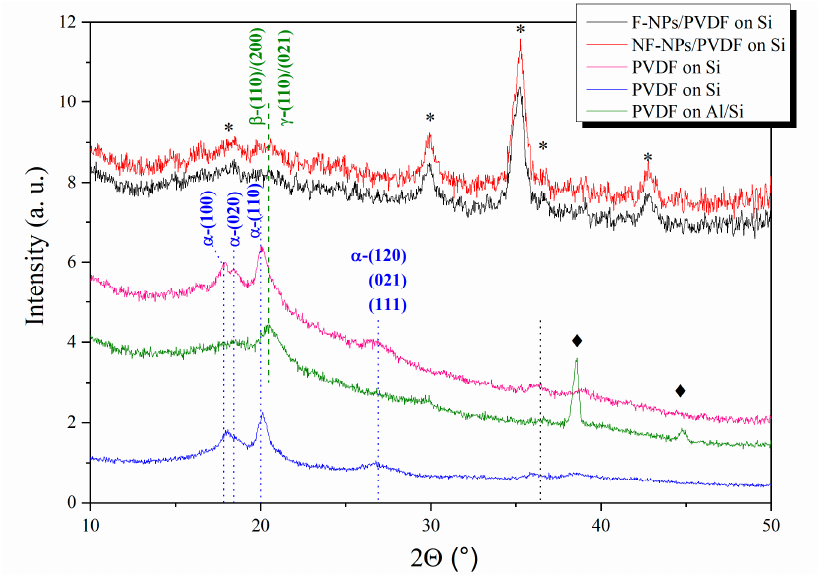
Figure 6. X-ray diffraction patterns acquired on several produced samples of neat PVDF thin films and composite ones. Details of different elaboration conditions of the films are reported in the main text. The main Bragg peaks of the PVDF α and β crystalline phases are indexed, as well as the diffraction lines associated with the crystalline spinel nanoparticles ( ∗ ) and with the aluminum ( ♦ ).